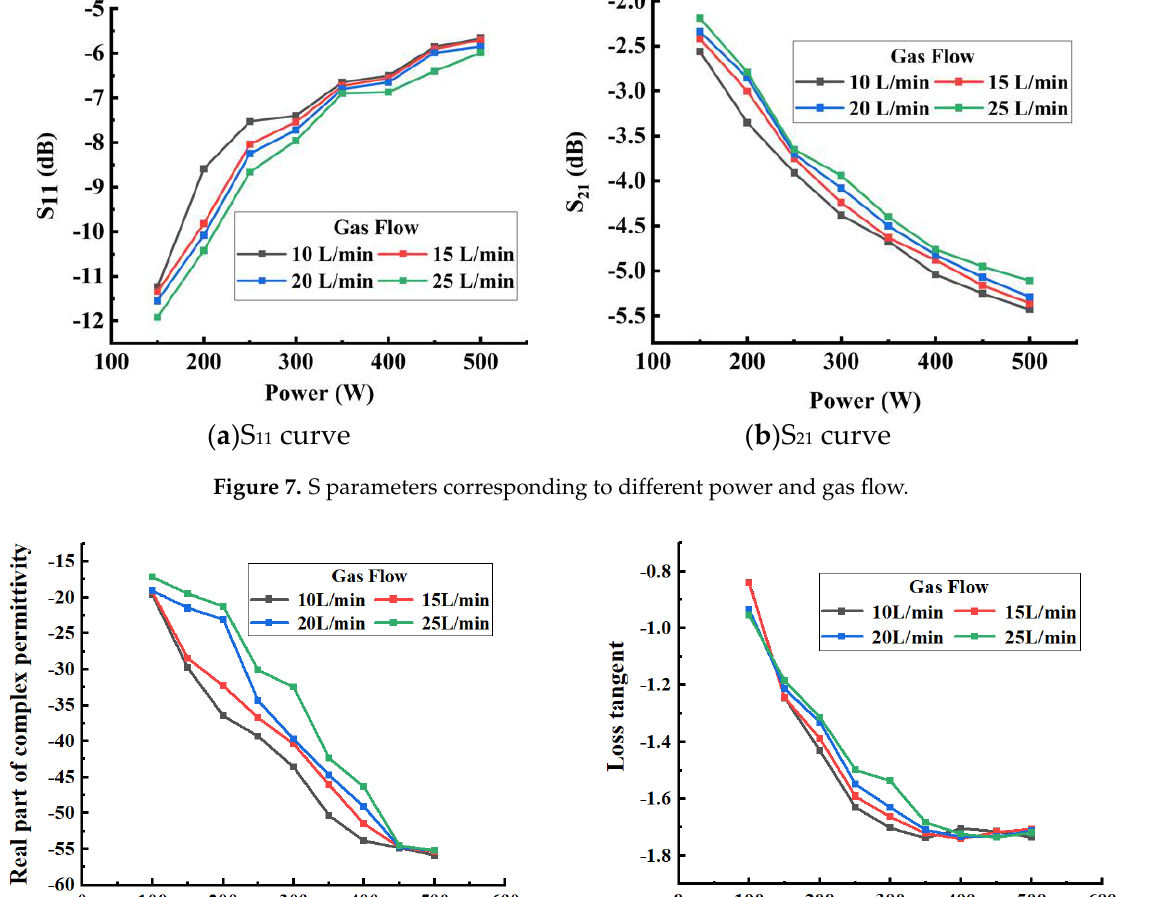
Figure 8. Real part of complex permittivity and loss tangent corresponding to different power and gas flow.